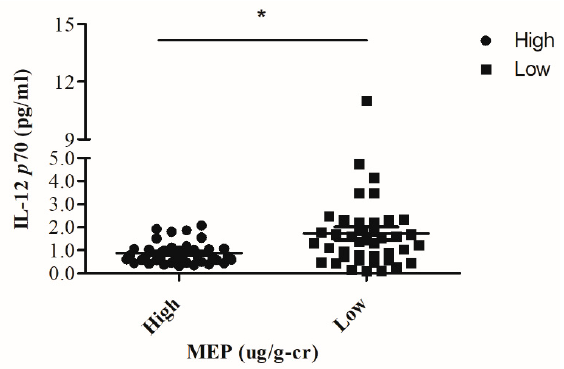
Figure 2. The study cases were divided into two groups according to the median value (9.2 μ g/g-cr) of the maternal urine MEP level. The high maternal urine MEP group showed a lower IL-12p70 level of paired cord blood plasma as compared with the low maternal urine MEP group (0.92 ± 0.01 pg/mL vs. 1.73 ± 0.01 pg/mL, p = 0.014). The cord blood plasma IL-12p70 levels were determined by ELISA. The * p value was determined with the Mann–Whitney U test.